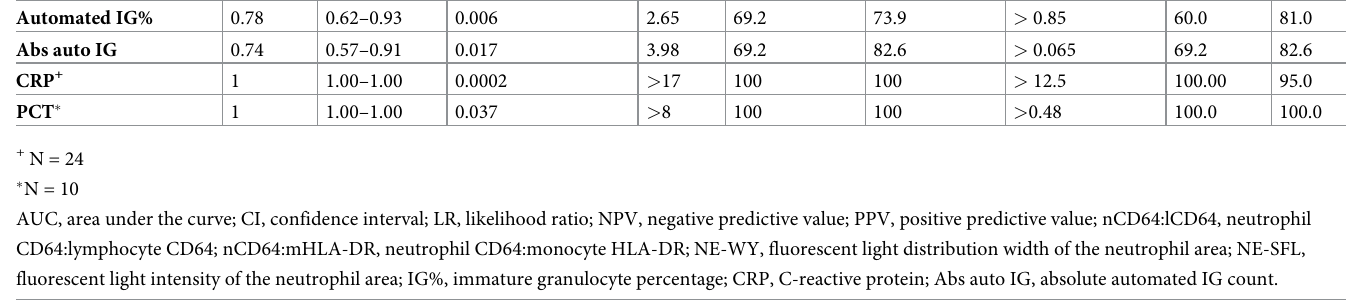
CD64:lymphocyte CD64; nCD64:mHLA-DR, neutrophil CD64:monocyte HLA-DR; NE-WY, fluorescent light distribution width of the neutrophil area; NE-SFL, fluorescent light intensity of the neutrophil area; IG%, immature granulocyte percentage; CRP, C-reactive protein; Abs auto IG, absolute automated IG count. bacteremia in the HIV negative group, but not among the HIV positive patients (S3 and S4